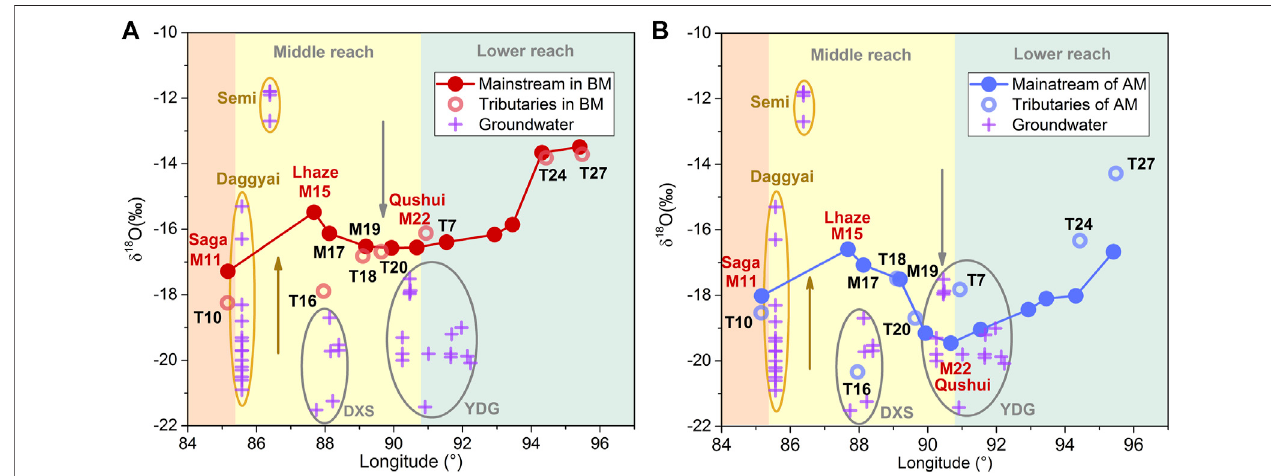
FIGURE7| Themainstream δ 18 Oisrepresentedby (A) reddotsforBMseriesand (B) bluedotsforAMseries,respectively.Theredcirclesin (A) andbluecirclesin (B) represent the δ 18 O of larger tributary con fl uences (e.g., Dogxung Tsangpo, Lhasa River, and Parlung Tsangpo) in BM and AM series. The isotopical composition valuesofgroundwater inSemi and Daggyaigeothermal fi eldarefrom Liu (2018) andLiu et al.(2019).Theothergroundwatervalues fortheDingjie-Xietongmen-Shenzha (DXS) and Yadong-Dangxiong-Gulu (YDG) faults are from Tan et al. (2014) and Tan et al. (2021).